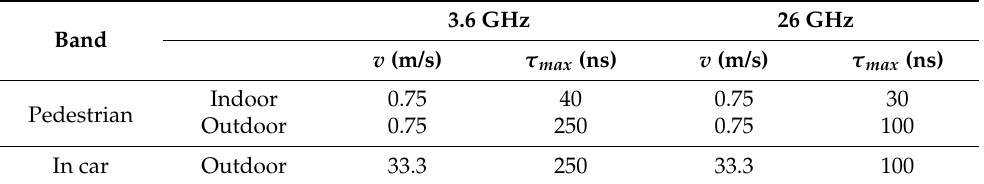
Table 1. Parameters of the propagation environments considered.